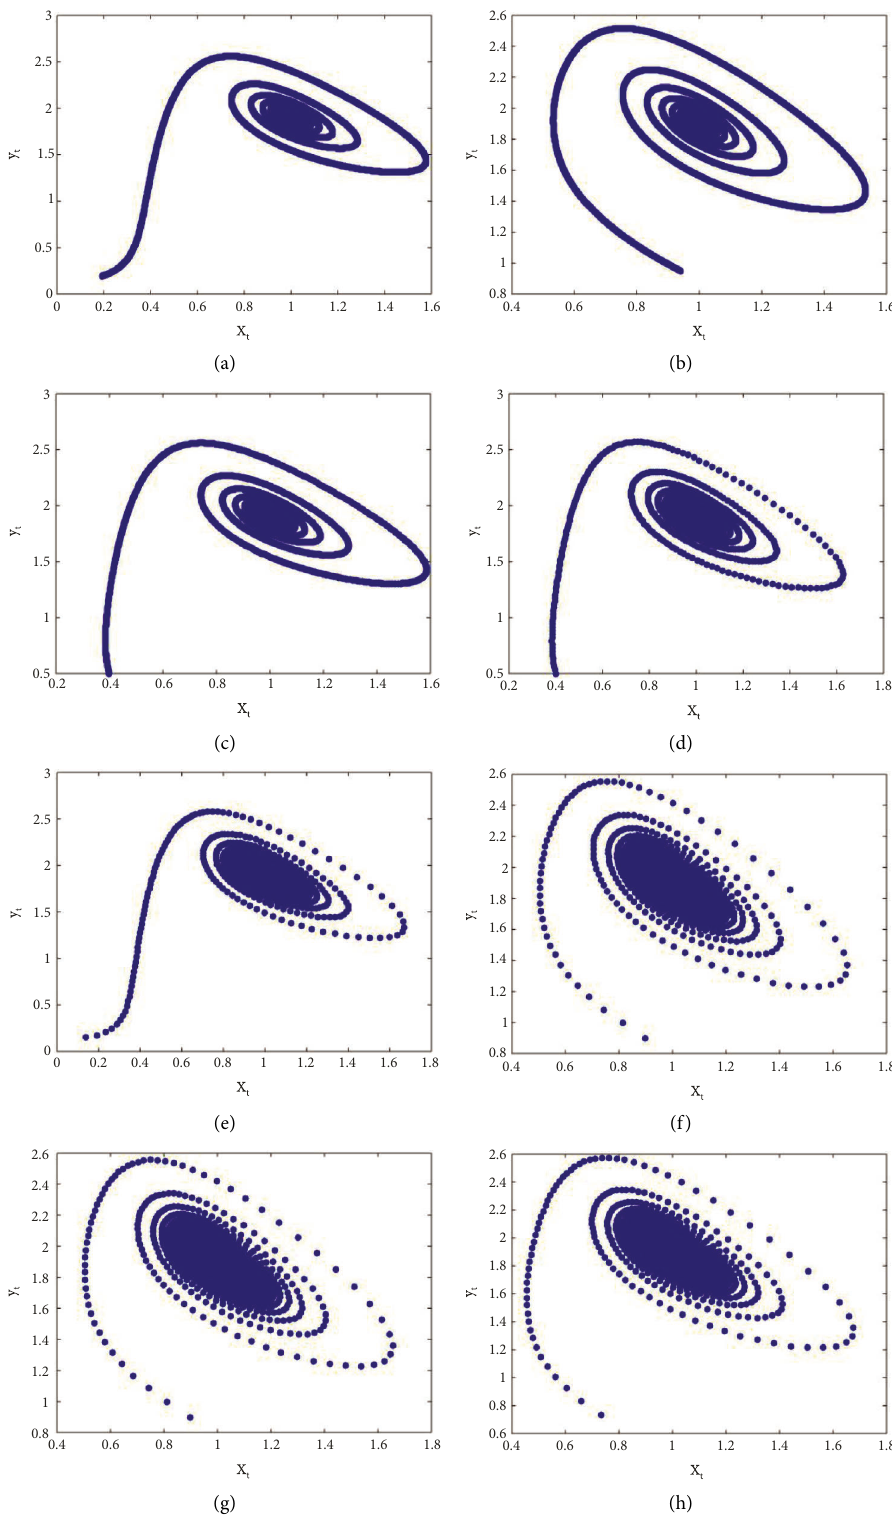
Figure 1: A stable focus of the Brusselator system (10). (a) h � 0.001 with (0.194, 0.195), (b) h � 0.001 with (0.94, 0.95), (c) h � 0.01 with (0.4, 0.5), (d) h � 0.05 with (0.4, 0.5), (e) h � 0.09 with (0.14, 0.15), (f) h � 0.098 with (0.9, 0.9), (g) h � 0.0987 with (0.9, 0.9), and (h) h � 0.0987 with (0.7345,